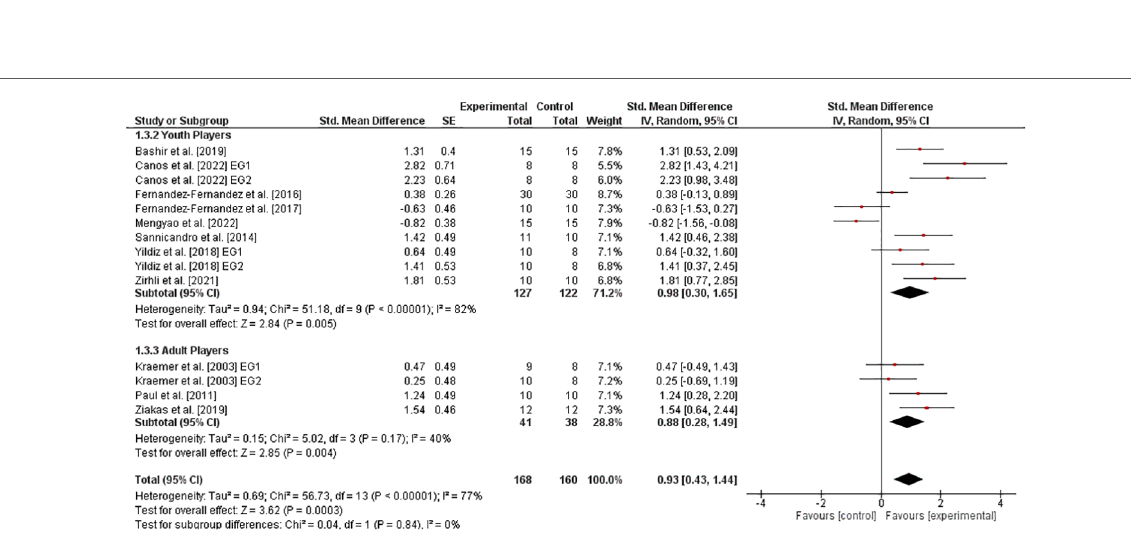
FIGURE 2 Effects of athletic training on measures of speed (e.g., 20 m sprint time) in healthy youth and adult tennis players. CI =con fi dence interval, df = degrees of freedom, SE =standard error, IV =inverse variance.